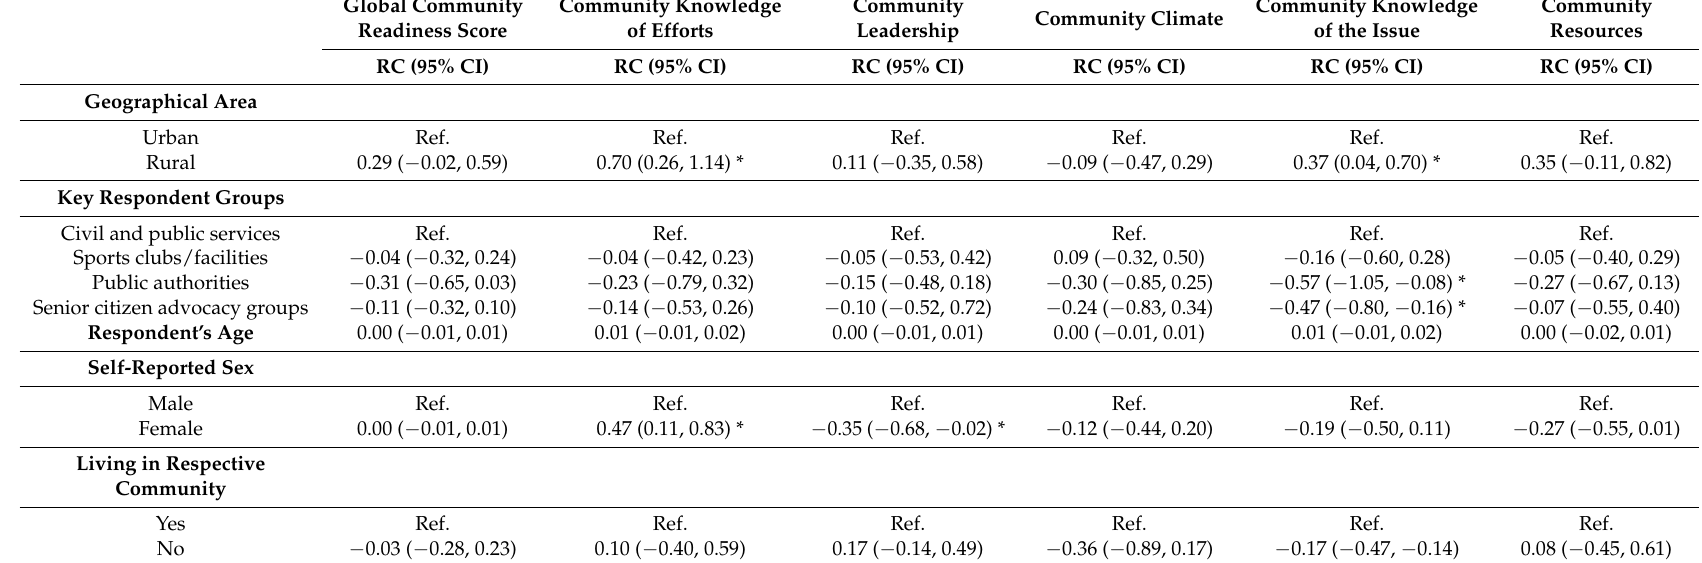
Table 3. Comparison of community readiness scores of rural versus urban